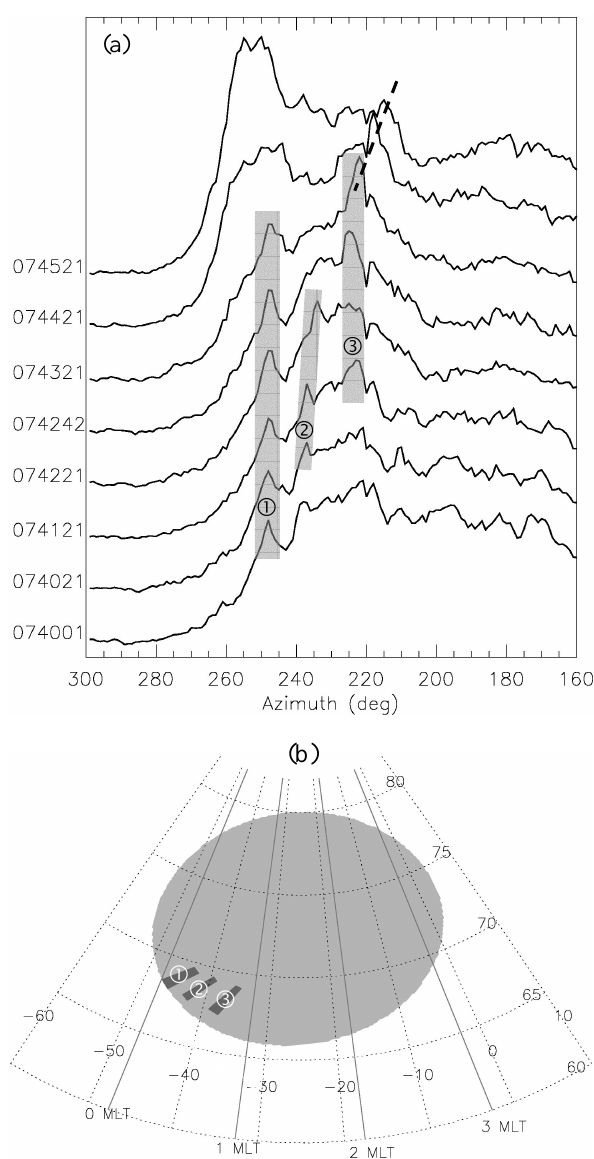
Fig. 9. Same as Fig. 8, but for the second pseudobreakup Figure 9 Same as Figure 8, but for the second pseudobreakup interval. Figure 9 Same as Figure 8, but for the second pseudobreakup interval.